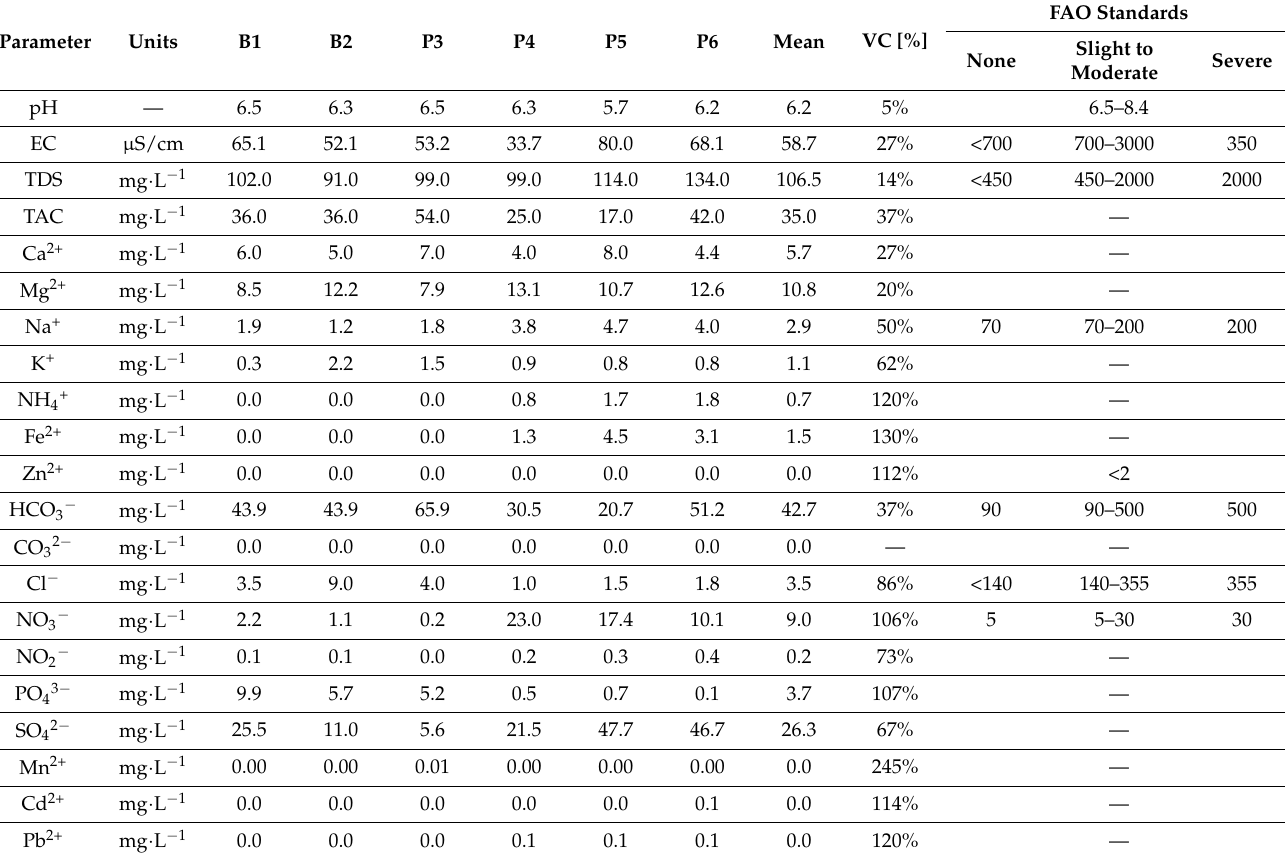
Table 2. Physicochemical parameters of groundwater (July